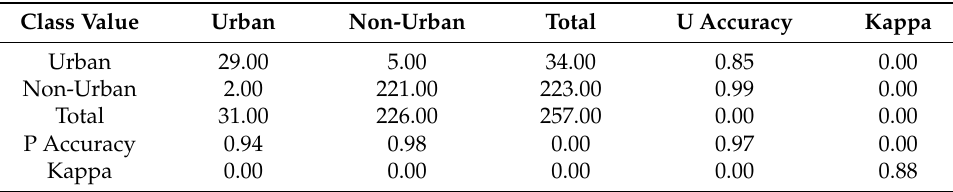
Figure 10. Distribution of Kappa validation points for 2022. Table 3. Kappa results for land use classification, 1984.